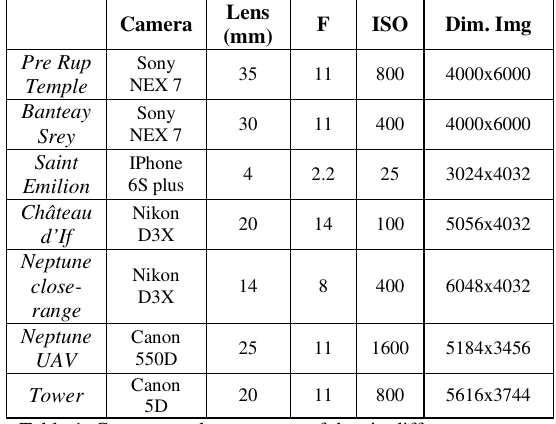
Figure 3. The Château d’If – Marseille